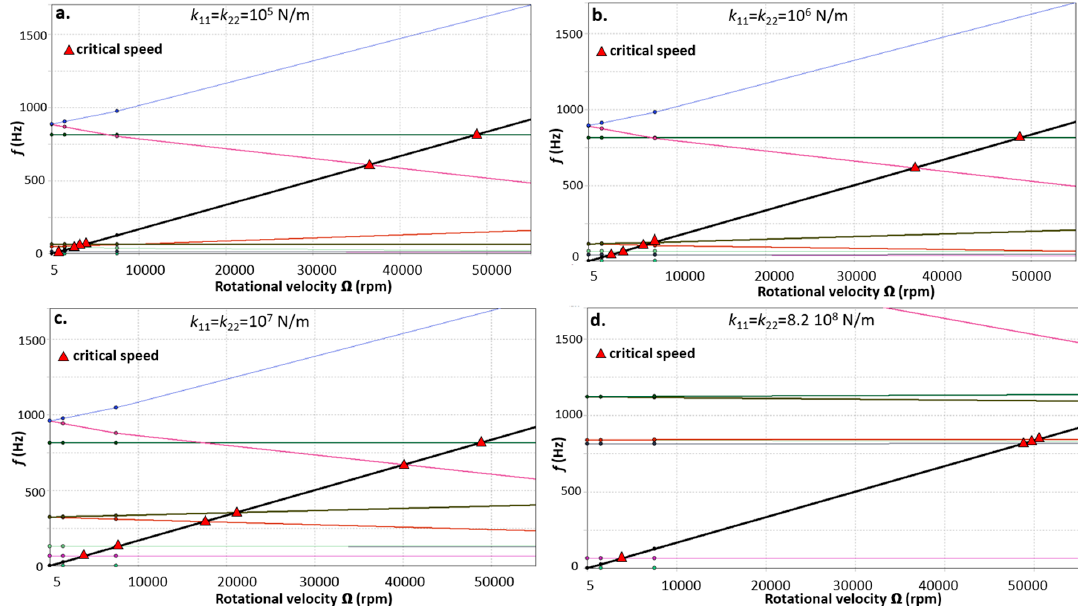
Figure 15. Critical speeds of the IPM rotor with the load represented in Campbell diagrams numerically calculated Figure 9 . ( a ) k 22 = 10 5 N/m, ( b ) k 11 = k 22 = 10 6 N/m, ( c ) k 11 = k 22 = 10 7 N/m, and ( d ) k 11 = k 22 = 8.2 × 10 8 N/m .